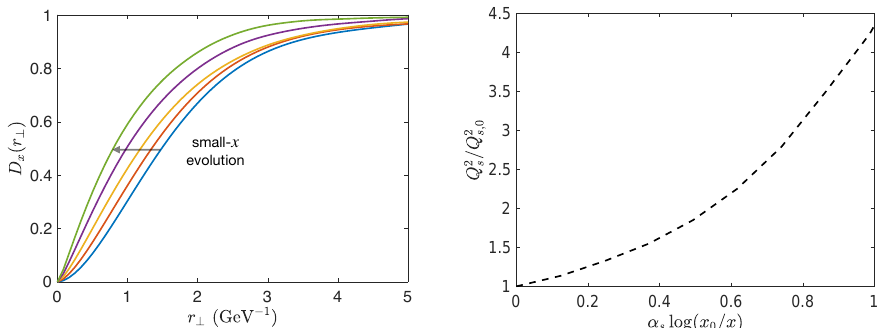
) small- x evolution drives a more rapid transition to the Figure 11. ( Left ) Dipole amplitude D x ( r ⊥ strong scattering regime. ( Right ) Small- x evolution of the saturation scale Q 2 s normalized by the saturation scale at x 0